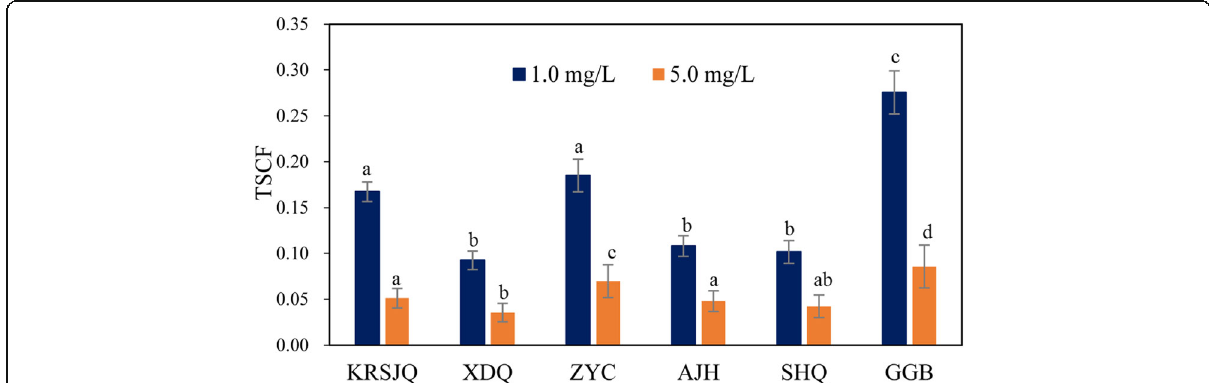
Fig. 3 The transpiration stream concentration factor (TSCF) for six vegetables (Kangresijiqing (KRSJQ), Xiadiqing (XDQ), Ziyoucai (ZYC), Aijiaohuang (AJH), Shanghaiqing (SHQ) and Gaogengbai (GGB)) in 1.0 mg/L and 5.0 mg/L treatments. Each treatment consisted of five replicates. The bars with the different letter(s) were significantly different ( p <